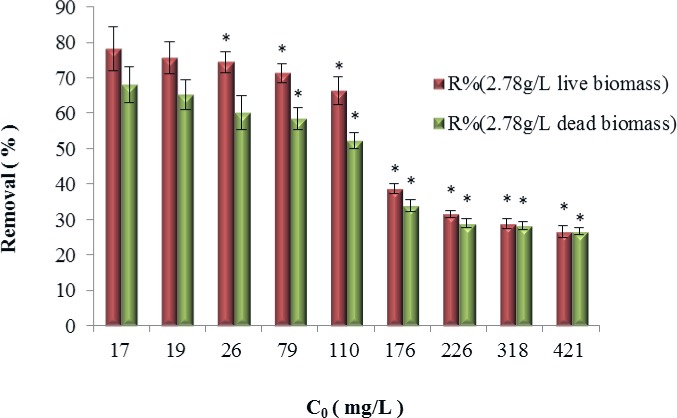
Removal efficiency of live and dead B. cereus S5 strain biomasses.(*p<0.05,*based on the value of 17mg/LCd2+, p value refers to the significant differences between the bars.)